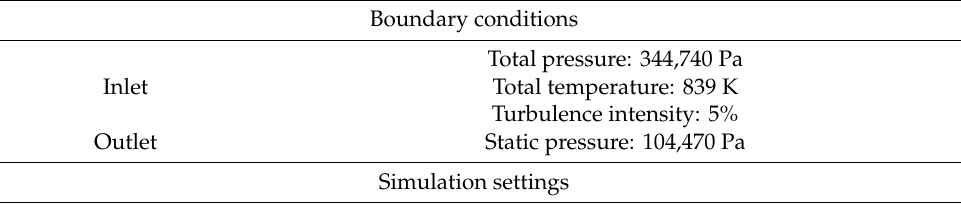
Table 2. Boundary conditions and simulation settings.